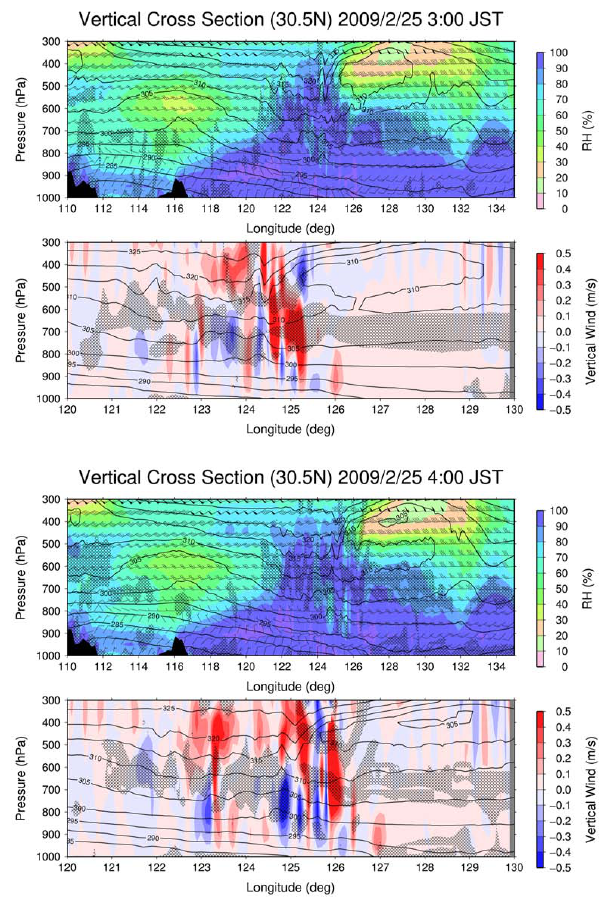
Fig. 12. Vertical-longitude cross-section of atmospheric variables at 30.5 ◦ N. The upper panel shows the relative humidity (colour), horizontal wind (each barb 10ms − 1 ), equivalent potential temper- ature (black contour with an interval of 5 ◦ ) and the unstable layer (shaded) with a negative bulk Richardson number. The lower panel shows the vertical wind speed (colour), equivalent potential temper- ature, and the unstable